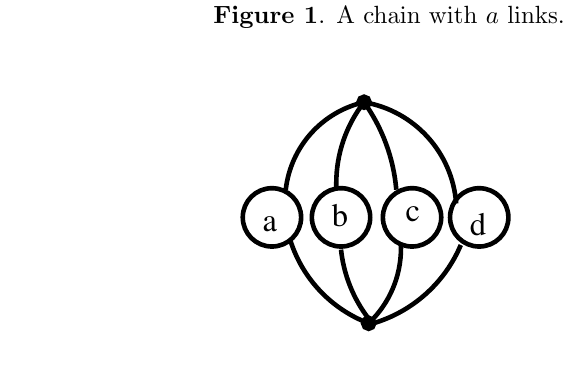
Figure 1 . A chain with a links.